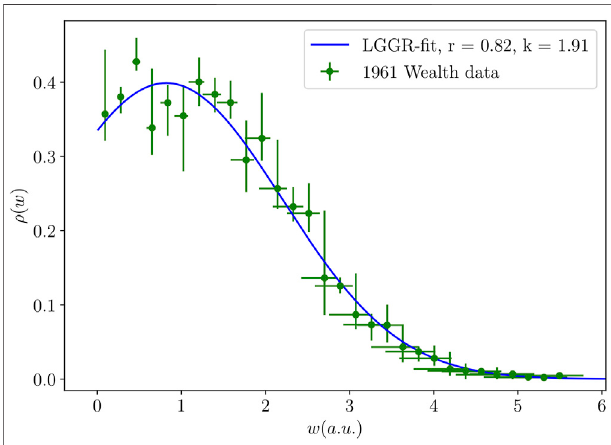
FIGURE 2 | Probability density for wealth distribution in 1961. Error bars are obtained by combining the results of the different weight parameter sets shown in Table 1 . Wealth values are given in arbitrary units (a.u.) as it is explained in Section 2.1 . The theoretical distribution (9) fi tted to the averaged experimental distribution ( k = 1.91 and r = 0.82) is shown by the continuous